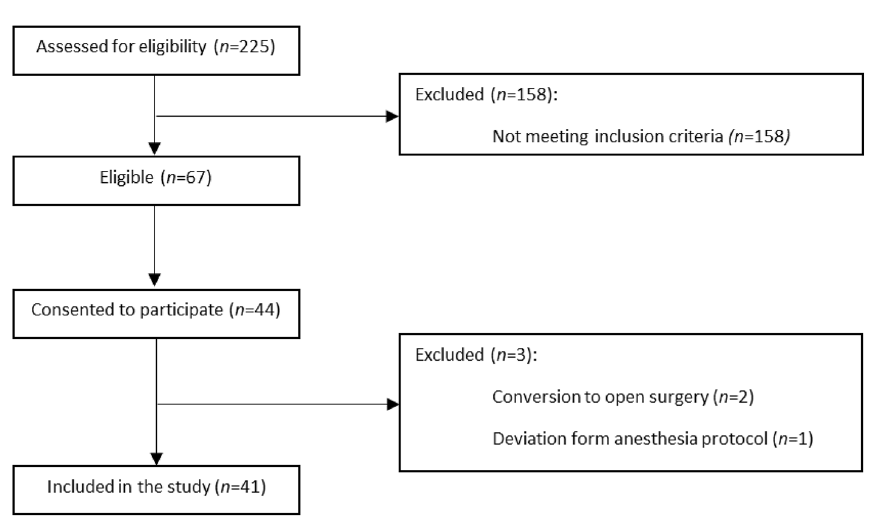
Figure 1. Consort diagram. Flowchart CHASE